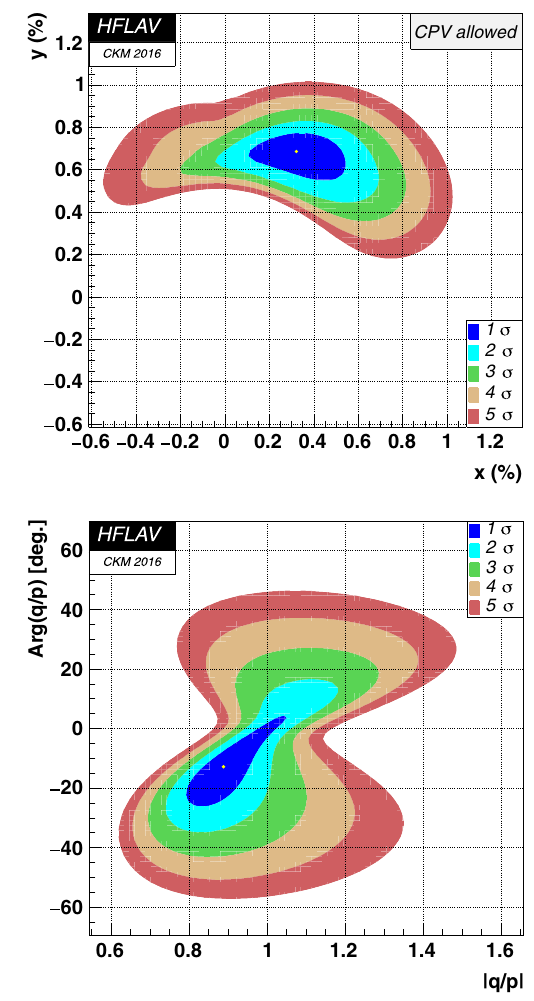
Fig. 196 Two-dimensional contours for parameters ( x , y ) ( top ) and ( | q / p | ,φ) ( bottom ), allowing for